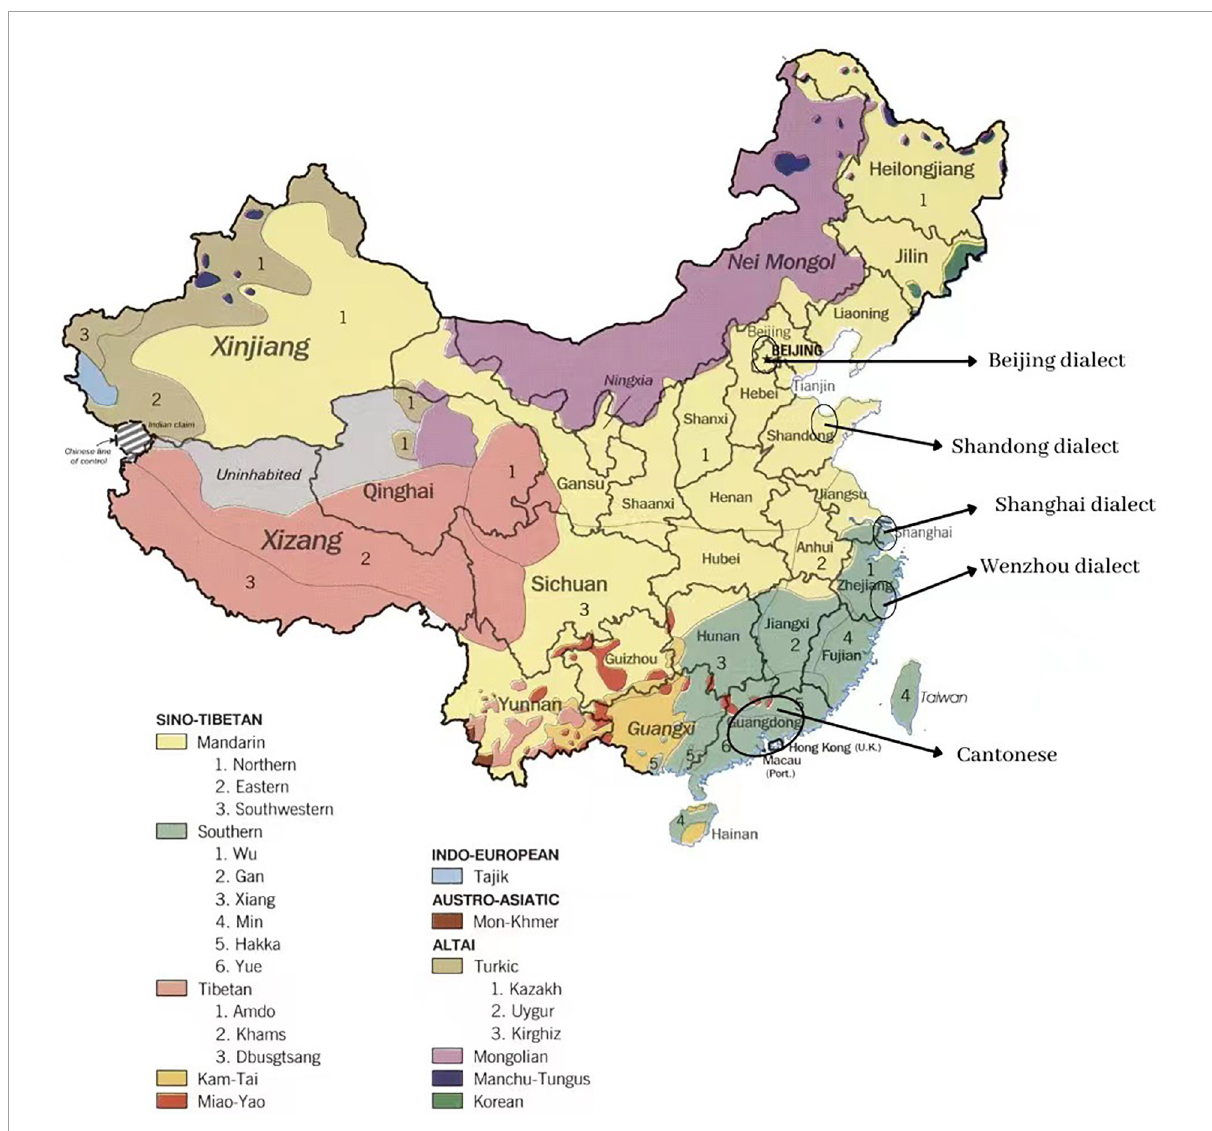
FIGURE1 Regional dialects included in this study. Adapted from Wikipedia “Languages of China.” Public Domain. Available at